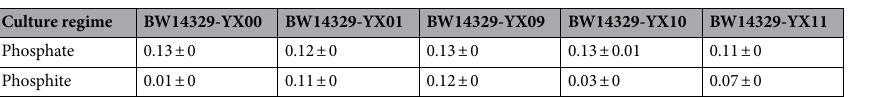
Table 1. Maximum specific growth rate (h −1 ) comparison between strains under different culture regime. All values reflect the average of three independent